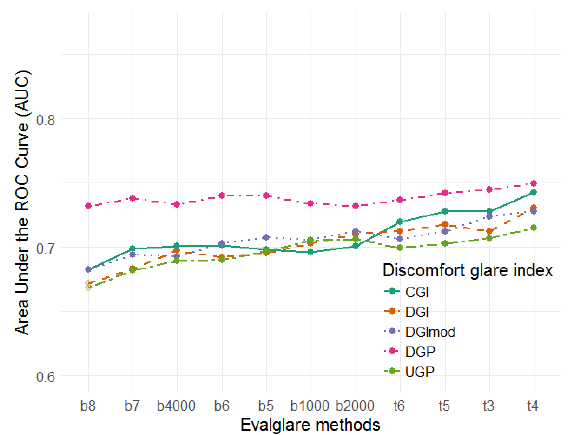
Figure 6. Comparison of Area Under the Curve (AUC) for each discomfort glare index between the studied evalglare methods (field study).